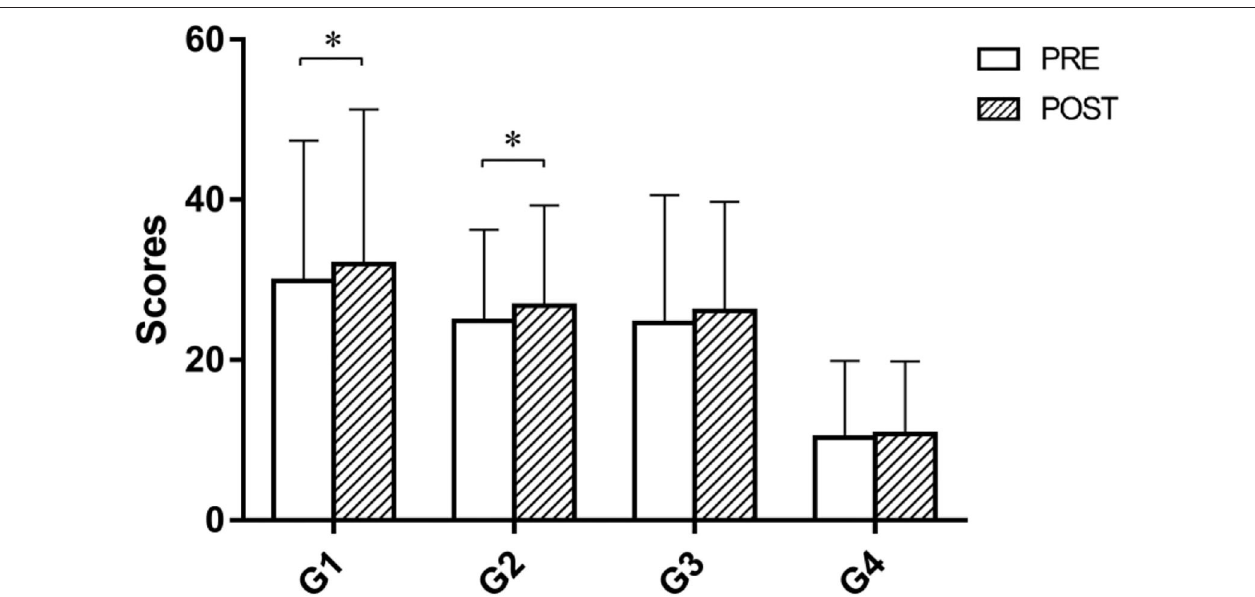
FIGURE 4 | Scores of four prescribed games pre and post priming before intervention in the MRT group. The scores of G1 and G2 were significantly improved after priming. G1, balloon collection; G2, goalkeeper; G3, water collection; G4, monster rescue. Error bars represent the standard deviation of the mean.* p < 0.05.